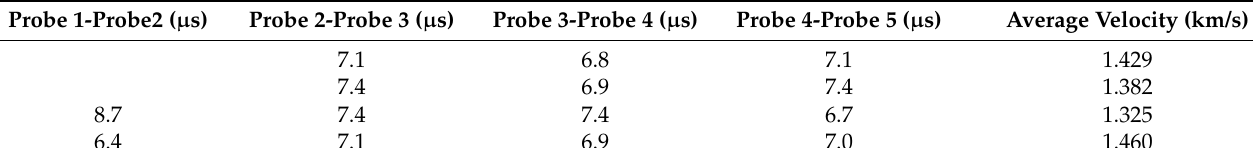
Table 5. Detonation velocity measurement results.